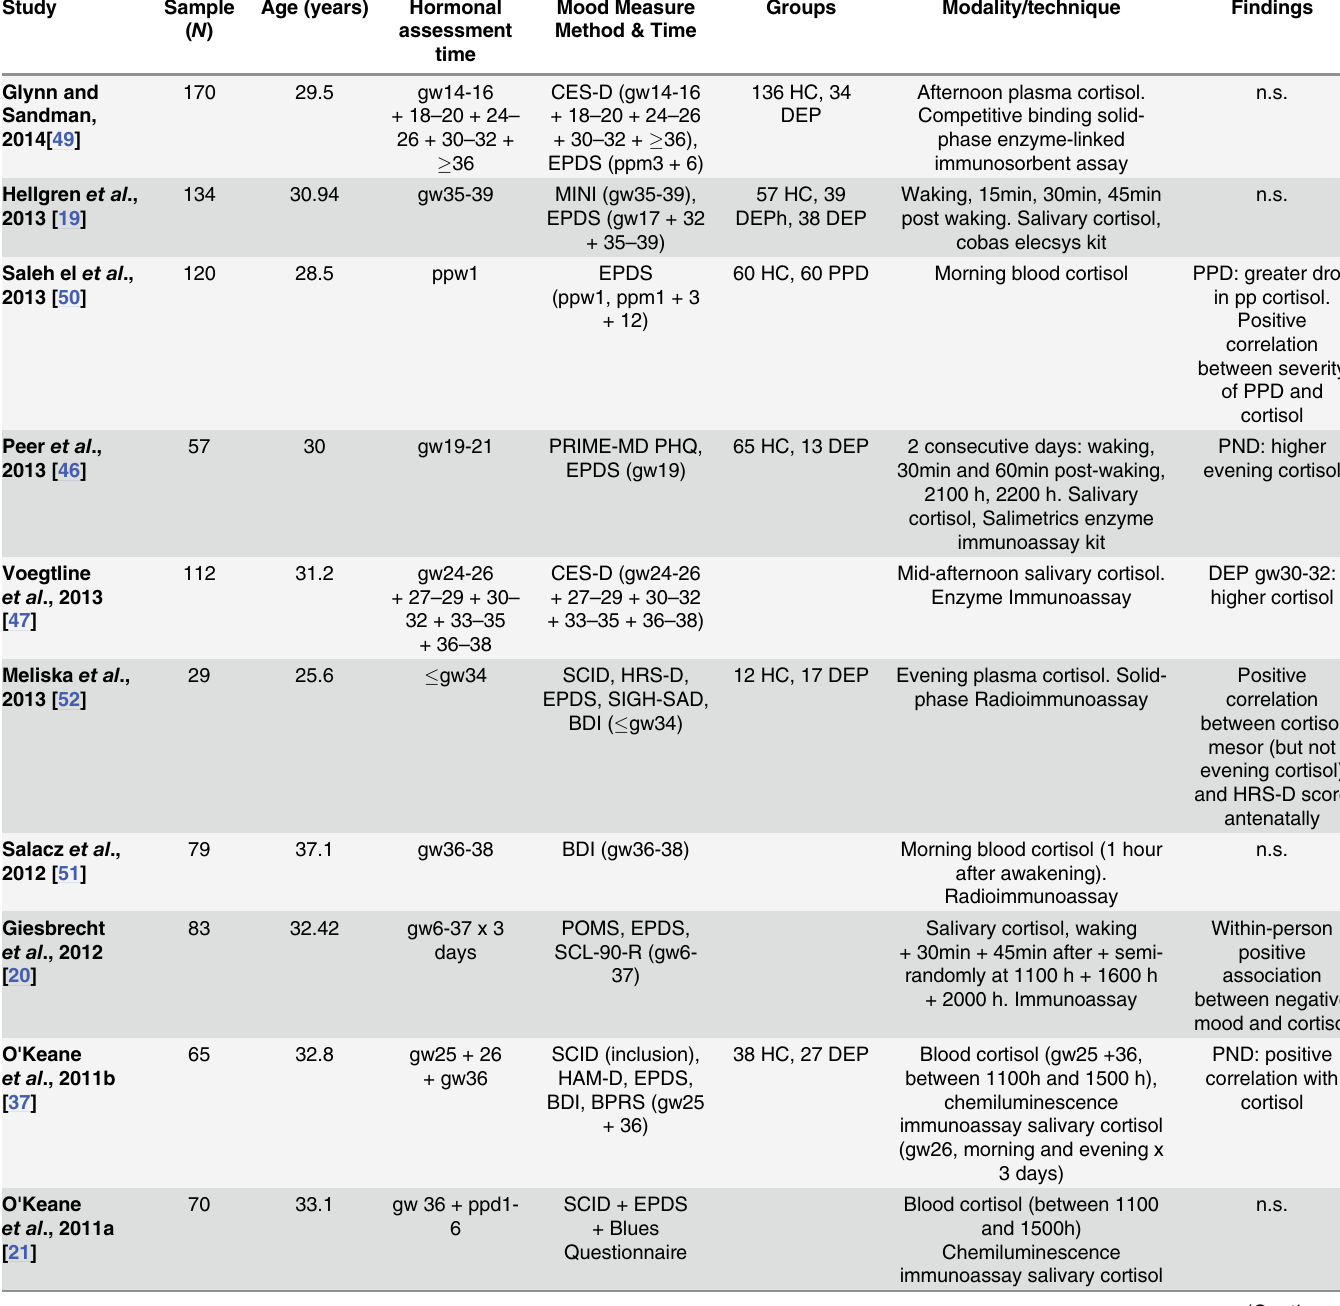
Table 1. Summary of studies assessing the relationship between peripartum cortisol levels and